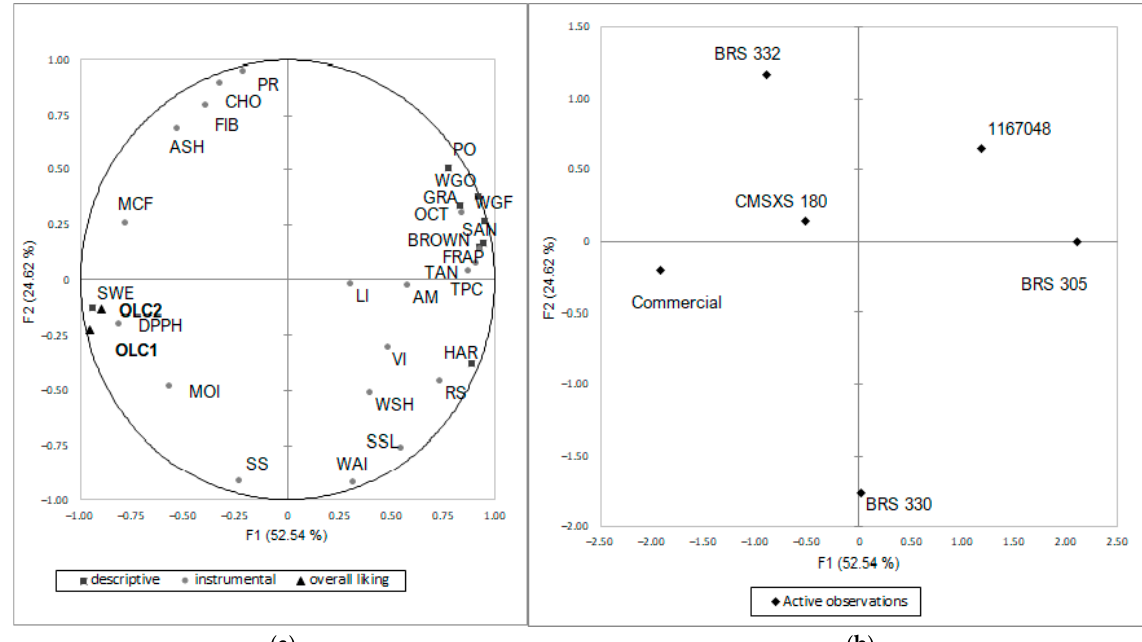
Figure 3. ( a ) MFA map. ( b ) Accession observations. Variables are: (1) Acceptance: